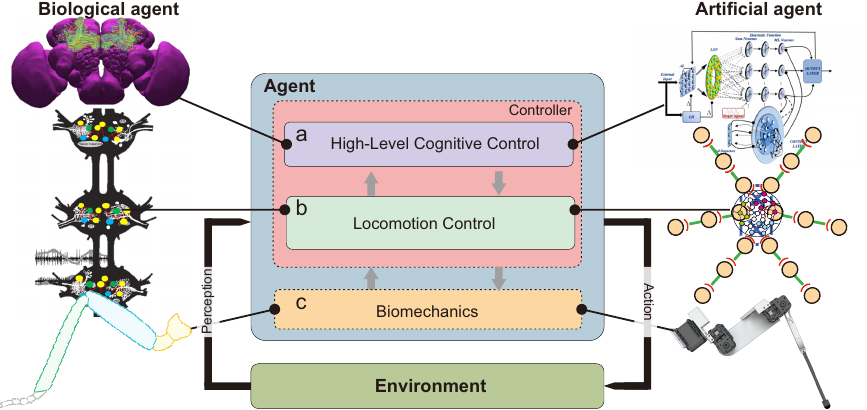
Figure 1. Overview of three main components underlying complex locomotion and cognition: biomechanics, locomotion control, and high-level cognitive control. Left (right) shows examples of the three components in insects (robots). ( a ) Left (right) is the insect central brain (high-level neural cognitive control model). ( b ) Left (right) is the insect thoracic ganglia (modified from [6]) (robot locomotion control model). ( c ) Left (right) is a biomechanical insect (robot)